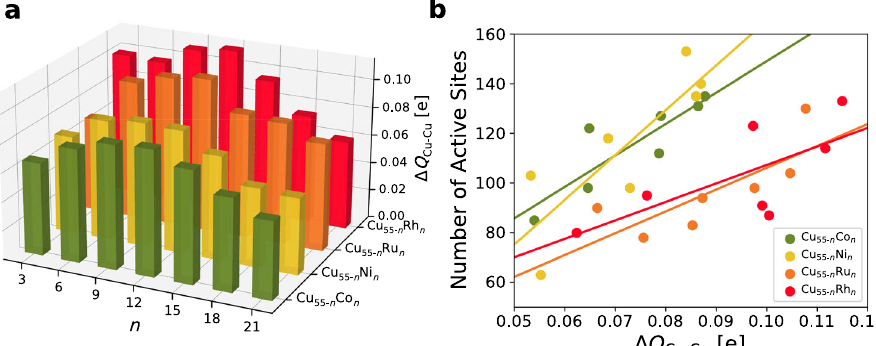
Fig. 7 Descriptor to evaluate HER performance. a The average charge difference Δ Q Cu-Cu between two adjacent Cu atoms on the edge site and vertical site for Cu 55- n M n (M = Co, Ni, Ru, and Rh) alloy clusters, b linear relationship between the number of active sites (| Δ G H | < 0.15 eV) and the average charge difference Δ Q Cu-Cu